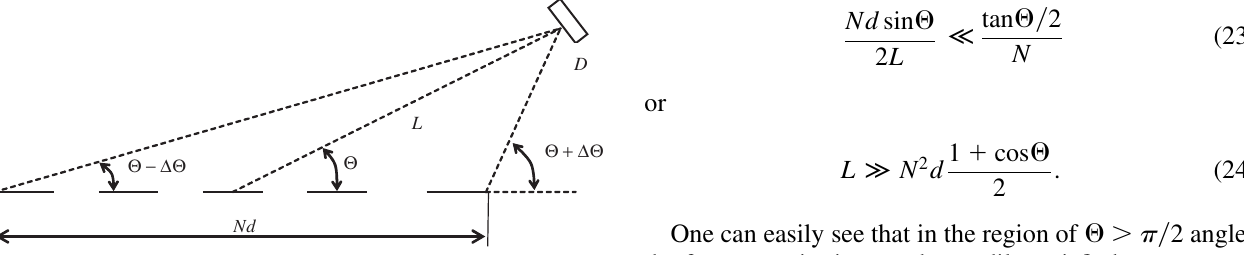
FIG. 14. A scheme of the detector disposition with respect to the